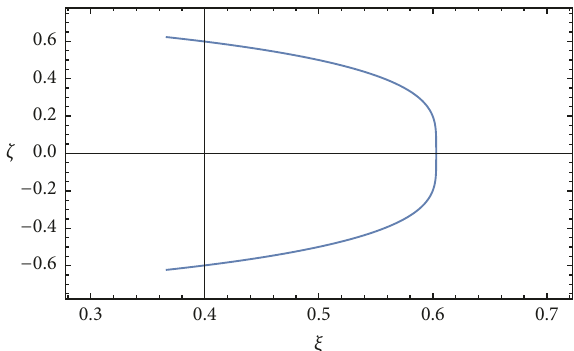
Figure 11: Positions of 𝐿 6,7 in the ( 𝜉 − 𝜁 ) plane as a function of oblateness 𝐴 in the interval [0,0.1] of PSR 1903+0327 for 𝑎 = 0.95, 𝜎 = 0.03 and 𝜎 = 1 2